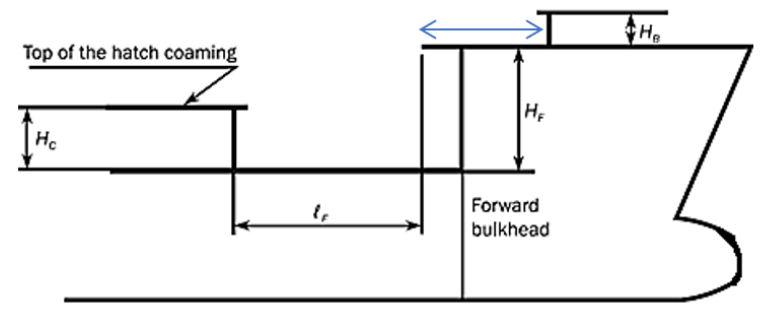
Figure 3. Breakwater location in forecastle arrangement.